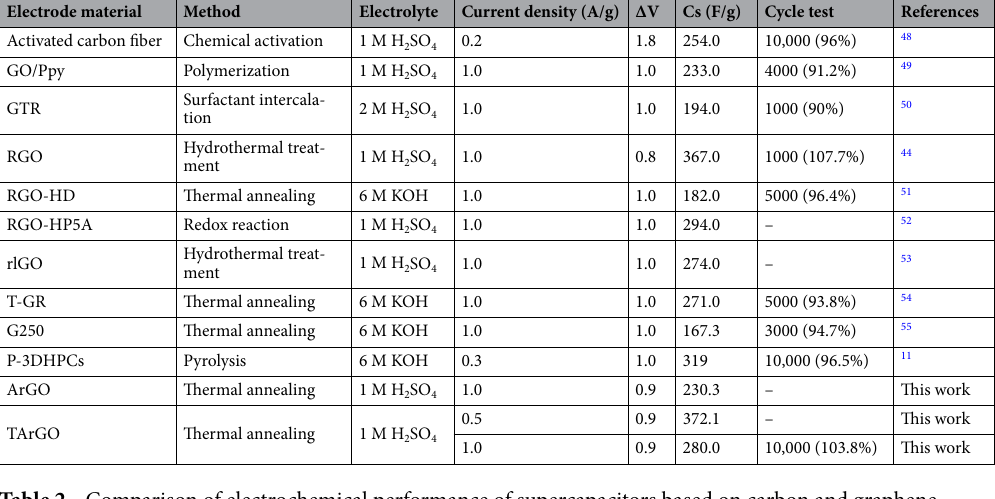
Table 2. Comparison of electrochemical performance of supercapacitors based on carbon and graphene